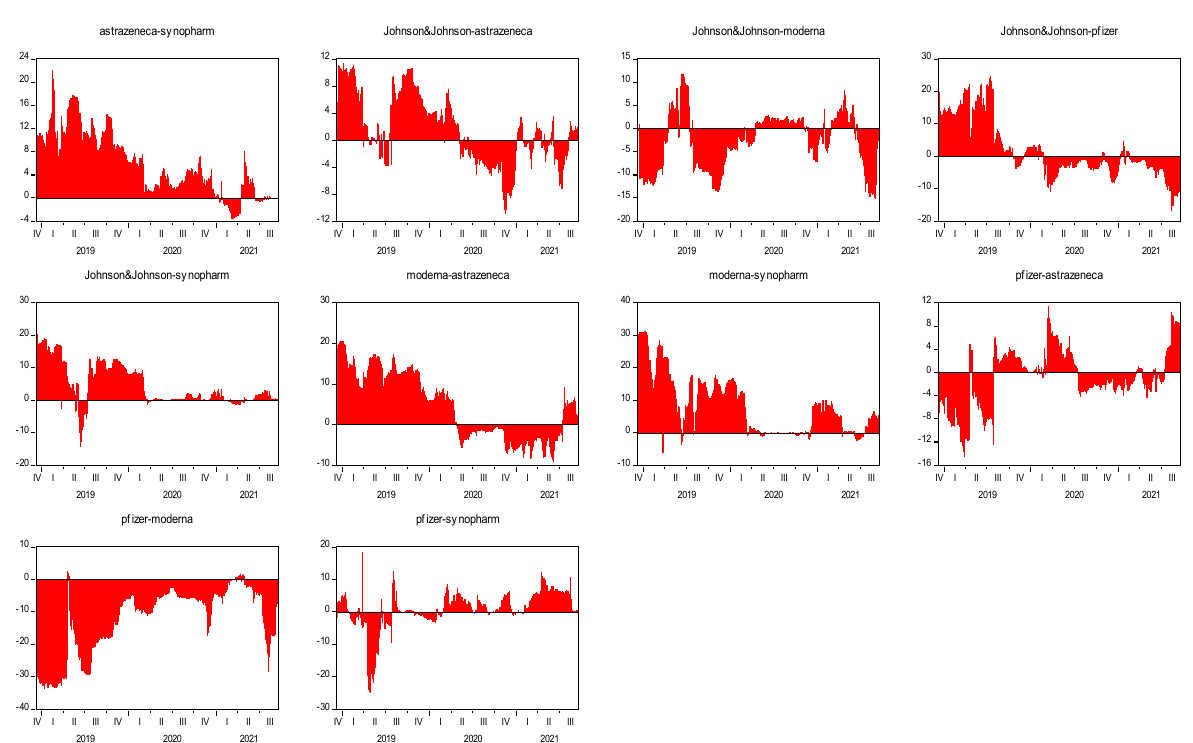
Figure 4. Volatility transmission from market to market.